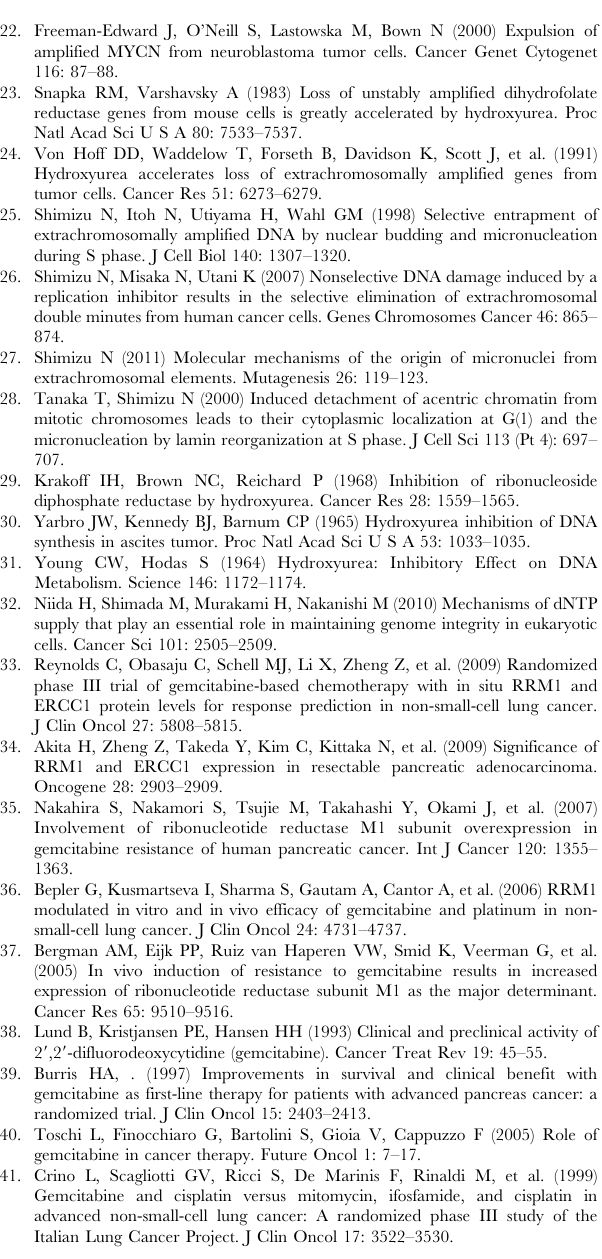
Table S3 MN and MN ( c - H2AX + ) frequency of HU and GEM treated UACC-1598-4 (48 hours after release)